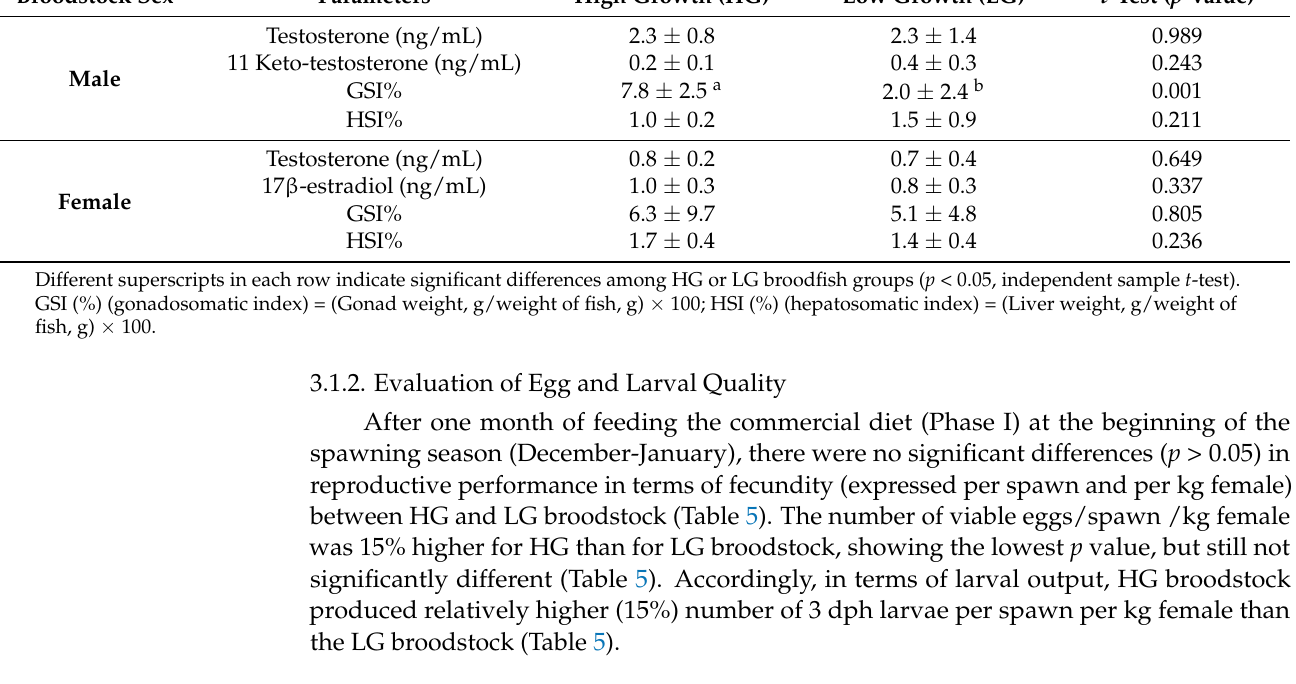
Table 4. Hepatosomatic, gonadosomatic index, steroid sex hormone levels of gilthead seabream male or female broodstock of high (HG) or low growth (LG) groups before feeding the experimental diets. Male-HG ( n = 6); Male-LG ( n = 7); Female-HG ( n = 6) and Female-LG ( n = 5).